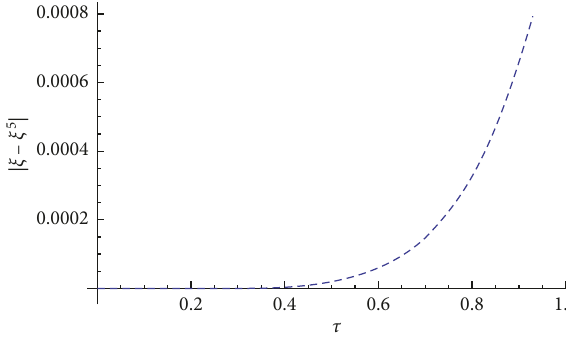
Figure 2: The absolute errors of Example 1.